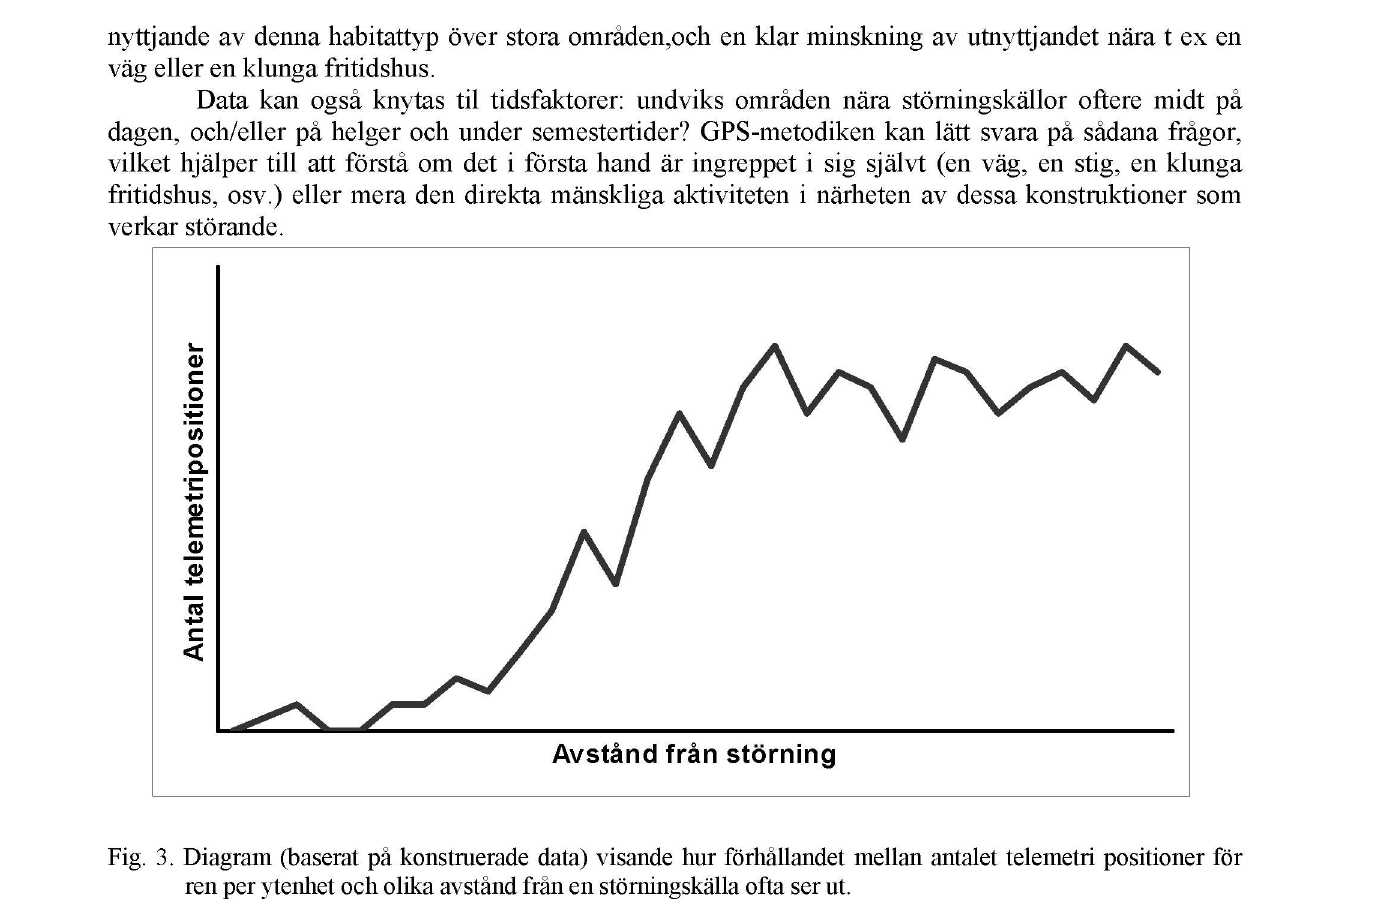
Fig. 3. Diagram (baserat på konstruerade data) visande hur férhållandet mellan antalet telemetri positioner